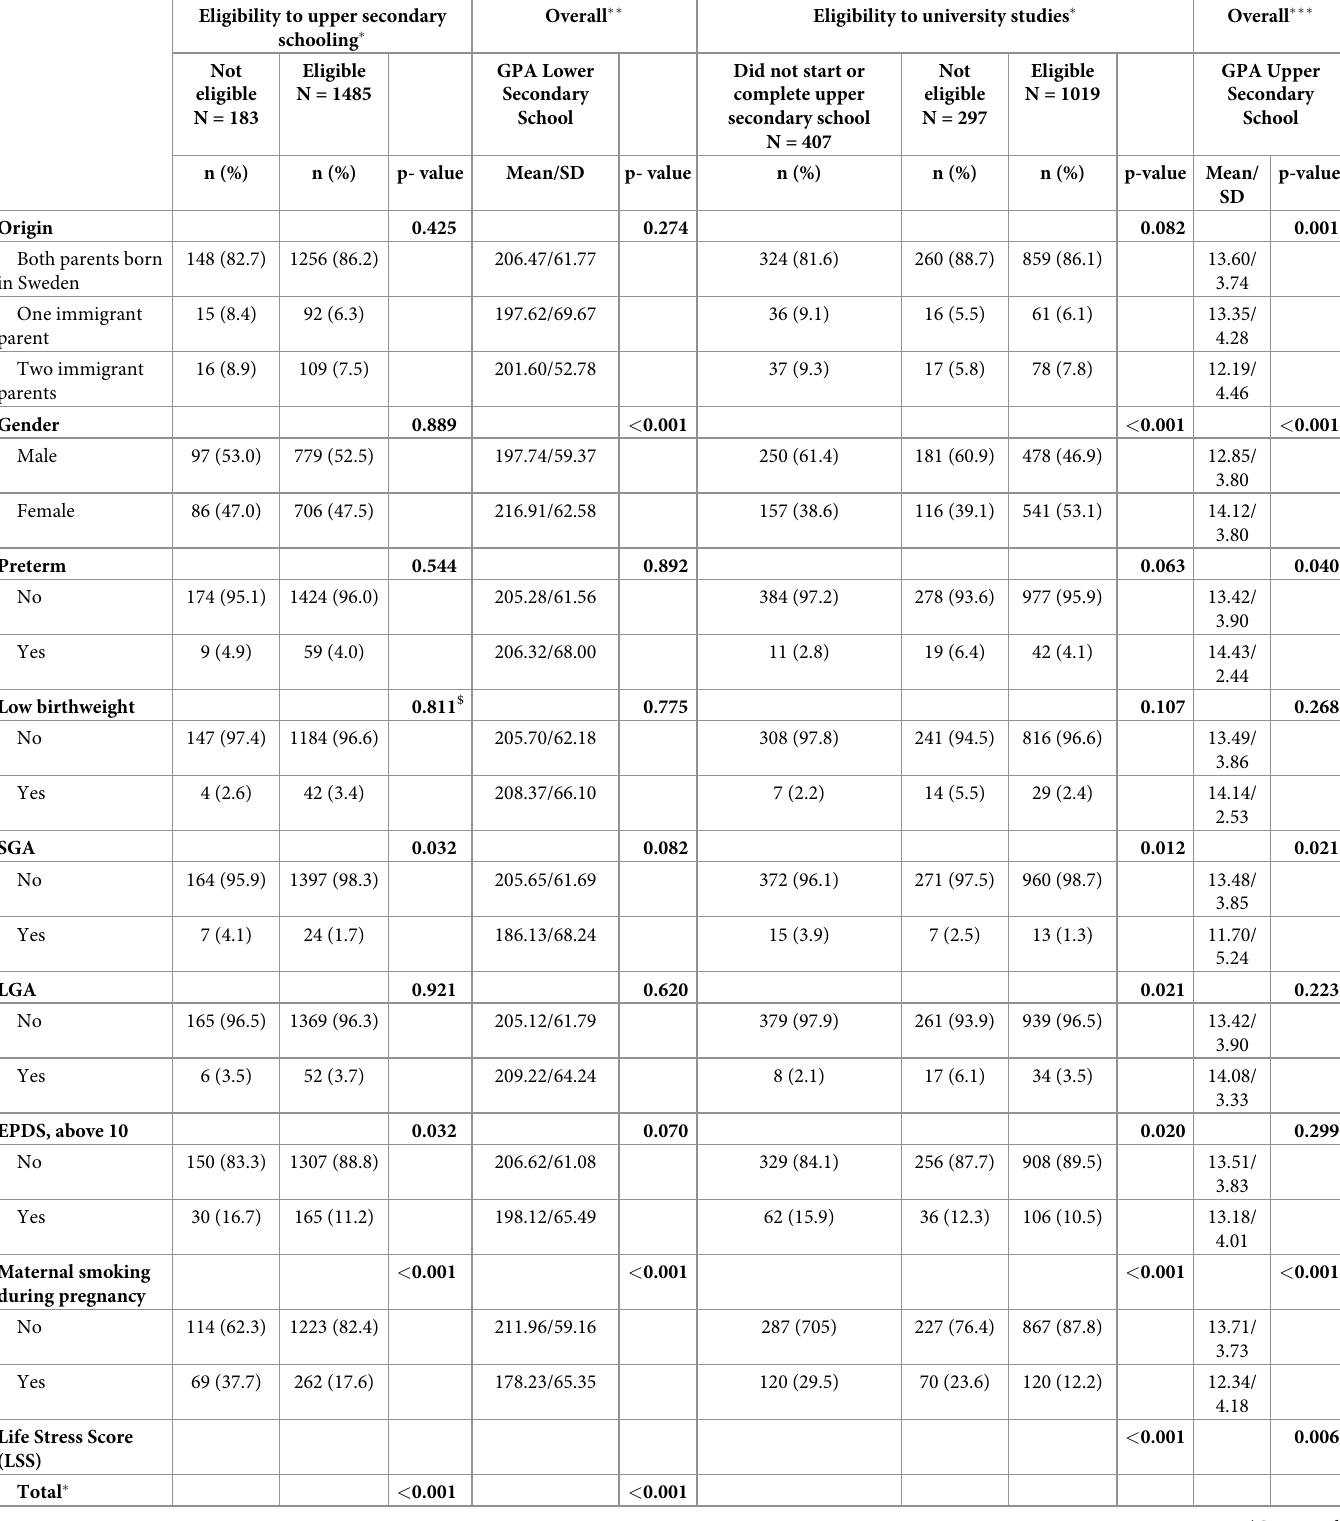
Table 1. Baseline information, sociodemographic background, life stress scale factors, and birth